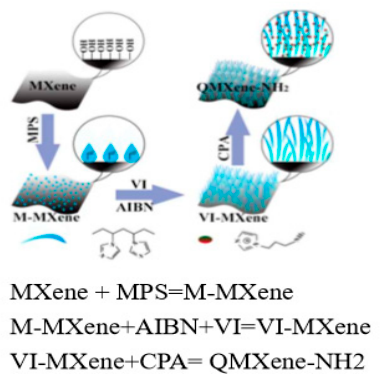
Figure 1. Schematic diagram for preparation process of QMXene-NH 2 .